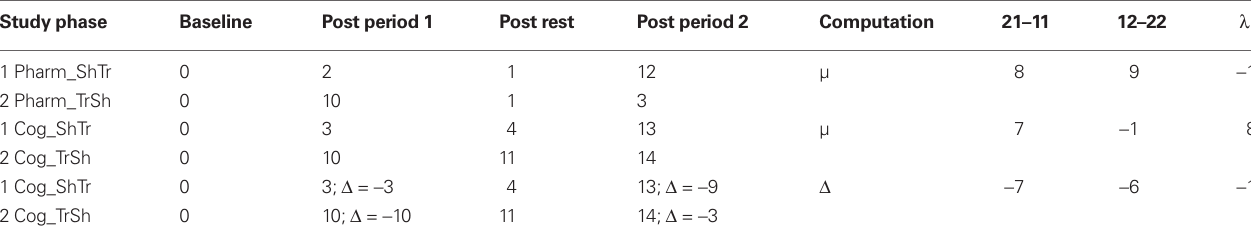
Table 3 | Schematic data comparing a pharmacological treatment study (Pharm) to a neurocognitive treatment study (Cog). Both are two period cross-over designs with a Sham First (ShTr) and a Treatment First (TrSh)